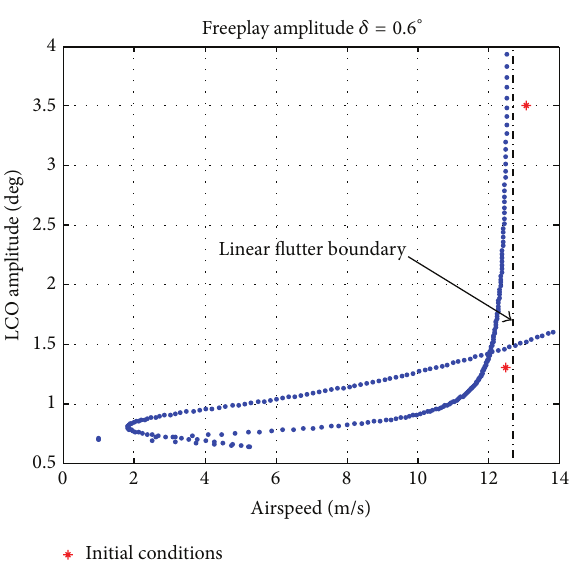
Figure 7: LCO prediction for |𝛿| = 0.6 ∘ .